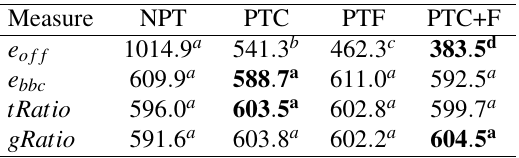
Table 3. Mean ranks returned by the Kruskal-Wallis non- parametric test for the global performance of NPT, PTC, PTF and PTC+F over the MPB with six different shift severities ( s = 1 ,..., 6). The superscripts indicate if there are differences among the methods at a significant level of 0 . 05 (Holm’s proce- dure). Different and equal superscripts in the same row indicate significant and non-significant differences for that measure, re- spectively. Best mean rankings are highlighted in